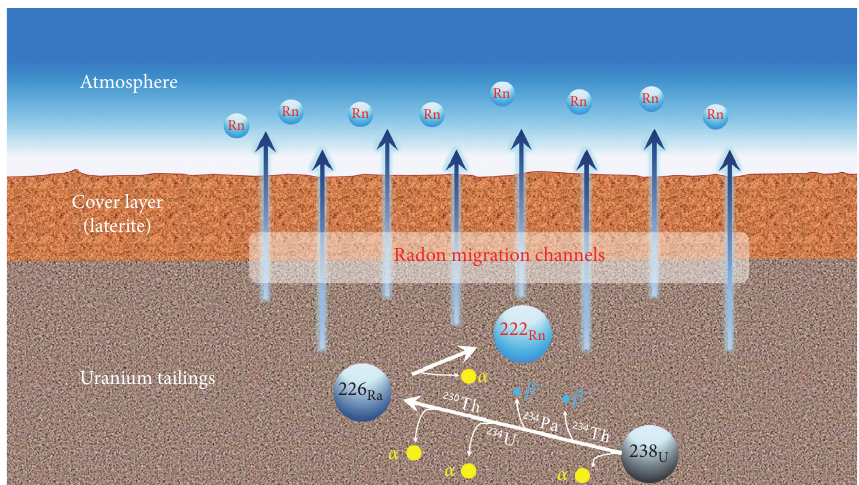
Figure 1: Theoretical model of radon exhalation. 238 U went through a series of decays to become 222 Rn. The blue arrow represents the direction of radon migration.